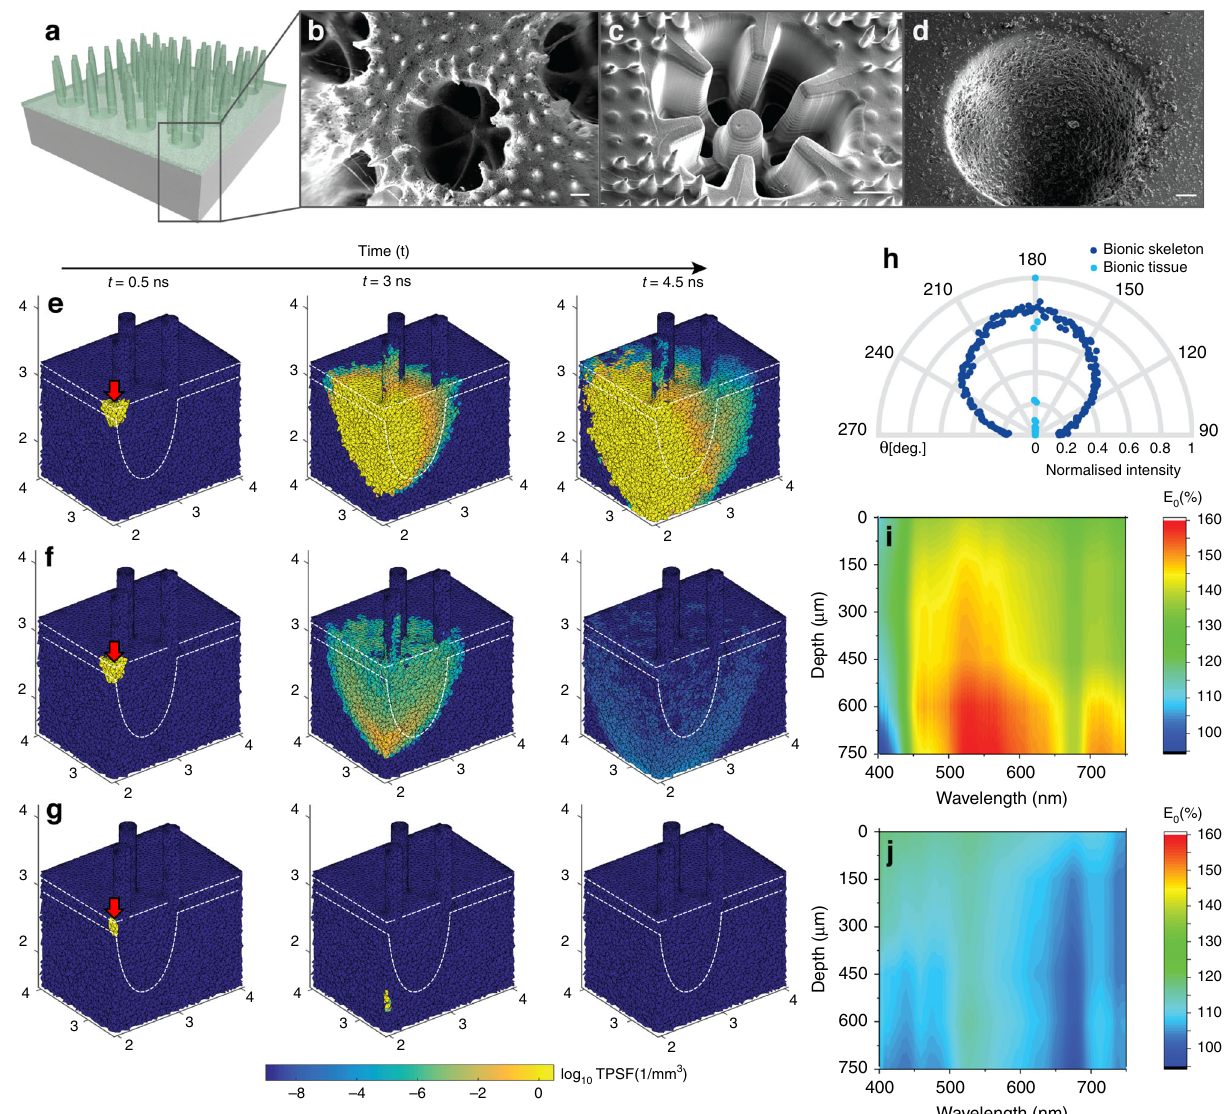
Fig. 2 Optical properties of 3D printed bionic coral tissue and skeleton. 3D rendering of fi nal bionic coral design ( a ). Bionic skeletal design optimization ( b – d ) showing SEM images of the original Stylophora pistillata corallite architecture (scale bar = 200 µ m) ( b ), a 3D printed intermediate skeleton design (scale bar = 300 µ m) ( c ) and the fi nal bionic skeleton doped with CNC aggregates (scale bar = 100 µ m) ( d ). 3D tetrahedral mesh-based Monte Carlo simulation ( e – g ). Light (675 nm) is irradiated over the connecting tissue (red arrow) as a collimated pencil beam. The time-resolved solution of photon migration (temporal point spread function, TPSF [1/mm 3 ]) is shown after 0.5 ns (left column), 3 ns (center column), and 4.5 ns (right column) in a cross- cut view of the 2-layer bionic coral ( e ), a 1-layer bionic tissue ( f ) and non-scattering GelMA ( g ). The microalgal density in the tissue component is identical for all simulations ( µ a = 15 mm − 1 ). The angular distribution of forward scattered light ( θ = 270° – 90°) at 550nm is shown as normalized transmittance ( h ). Microprobe-based fl uence rate measurements (E 0 in % of incident irradiance) for the bionic coral ( i ) and a fl at slab of GelMA ( j ) both with a microalgal density of 5.0 × 10 6 cells mL − 1 Compared to a fl at slab of biopolymer (GelMA) with the same microalgal density (5.0 × 10 6 cells mL − 1 ), the scalar irradiance (for 600 nm light) measured in the photosynthetic layer of